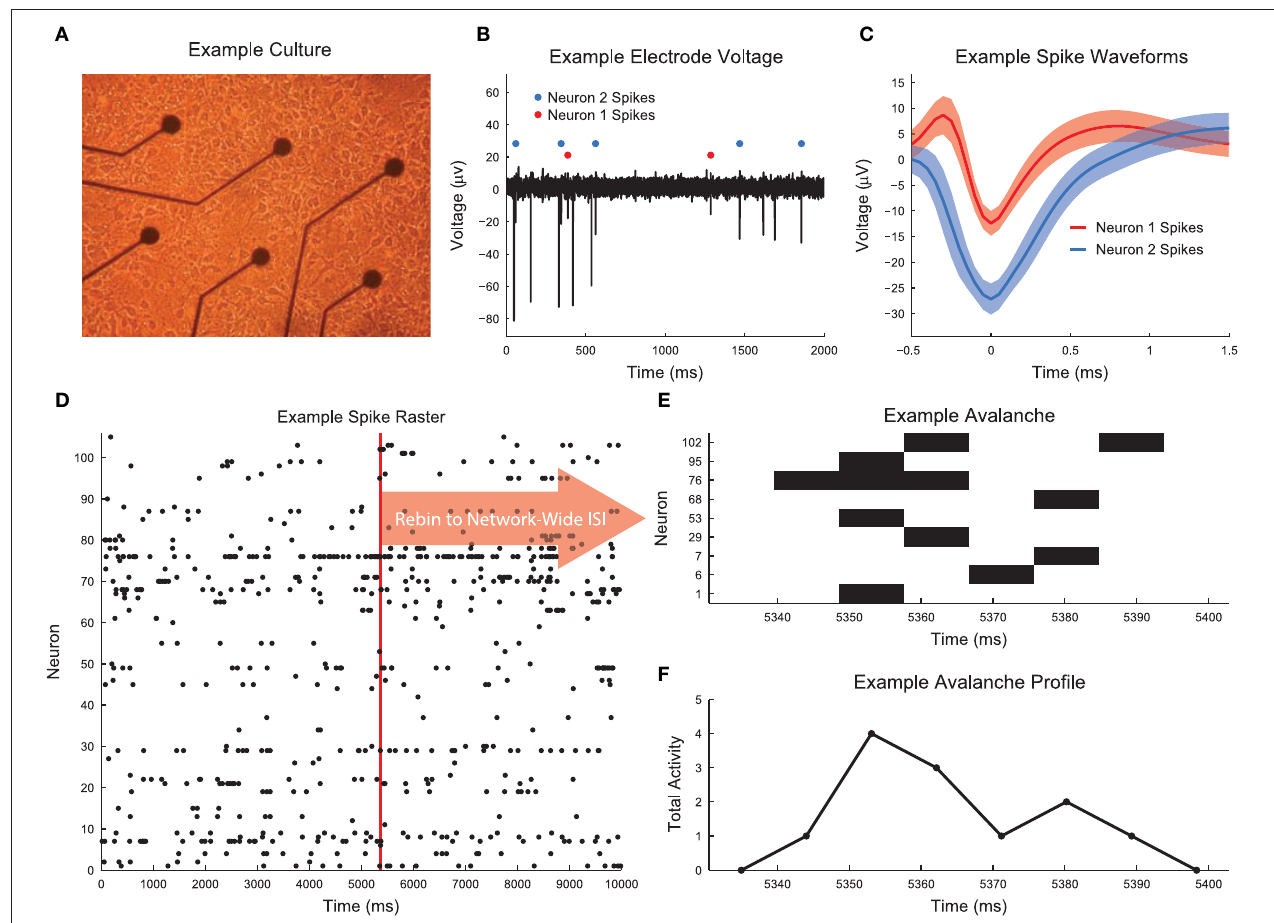
FIGURE 1 | Culture recording, spike sorting, and avalanche detection. (A) Image of example low density dissociated hippocampal culture plated on the electrode array (50,000 cells, DIV 6). Low density culture produced for testing and imaging purposes. High density cultures (as used in the analysis) were difficult to image due to overlapping cell structure. (B) Example voltage recording from a culture that was utilized in the analysis. Spike sorting identified two neurons. (C) Average spike waveforms for neurons 1 and 2 from (B) . Solid line represents mean voltage and fringe represents one standard deviation. (D) A segment of the spike raster for all electrodes in the same culture as the electrode shown in (B) . (E) Example neuronal avalanche. Once spikes were found for all electrodes with a temporal resolution of 0.05 ms, the data were rebinned to the mean network-wide interspike interval (ISI). Adjacent periods of activity were then identified as avalanches. This avalanche corresponds to the red vertical line in (D) . This avalanche was duration 6 (6 time bins long) and size 12 (12 total neuron activations). (F) Avalanche profile for the example avalanche shown in (E) .